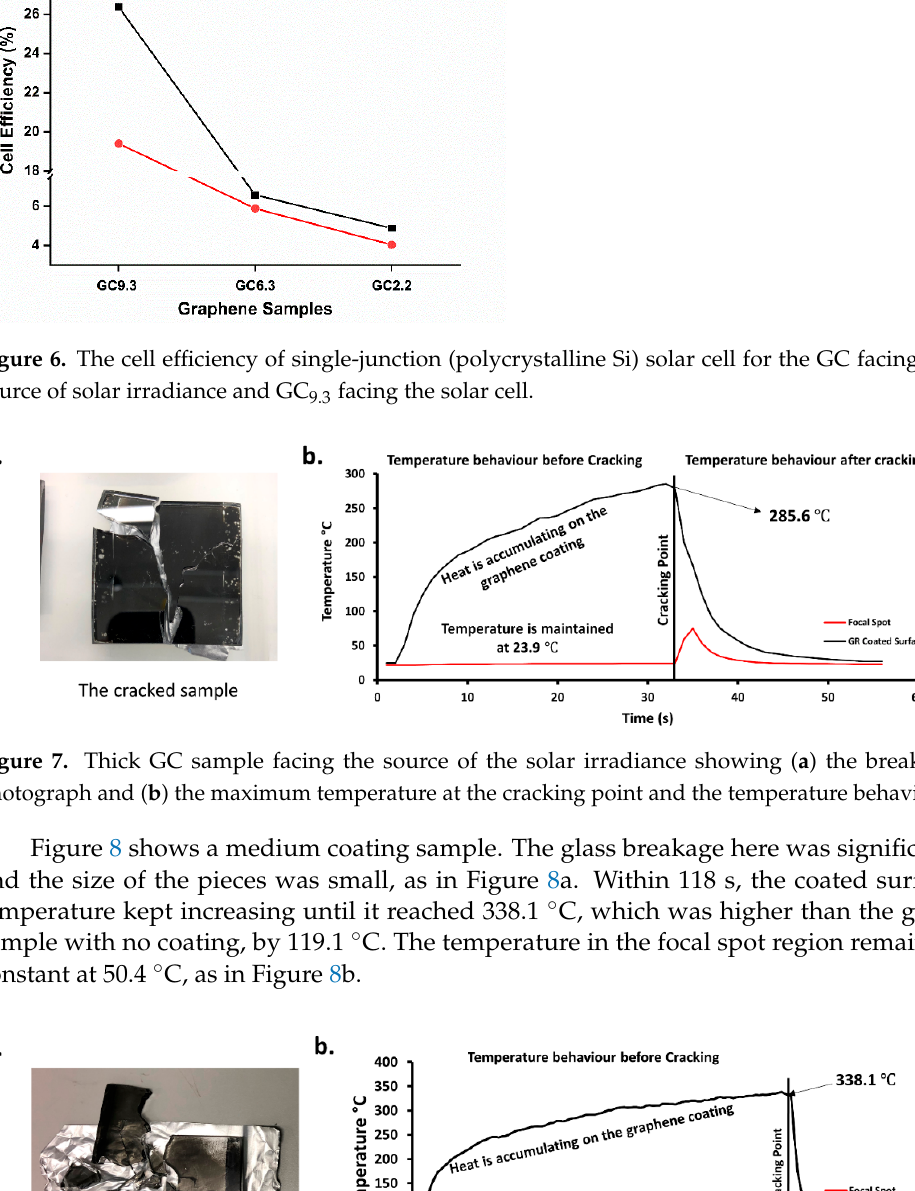
Figure 6. The cell efficiency of single-junction (polycrystalline Si) solar cell for the GC facing the source of solar irradiance and GC 9.3 facing the solar cell.